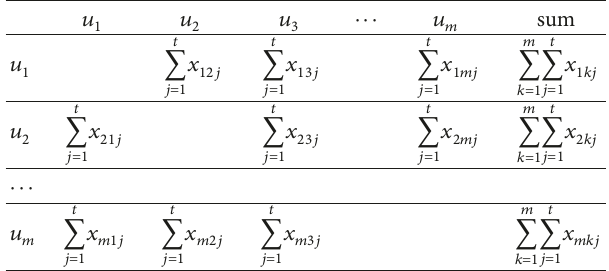
is calculated. In doing so, we need to grade each criterion based on specialist consultancy. We can get the member- ship vector 𝑅 𝑗 of criterion 𝑢 𝑖 to evaluation set 𝑉 . 𝑅 𝑗 = , 𝑟 , 𝑟 , 𝑟 ), 𝑗 = 1, 2, . . . , 𝑚 × 𝑛 , 𝑟 (𝑟 𝑗1 𝑗2 𝑗3 𝑗4